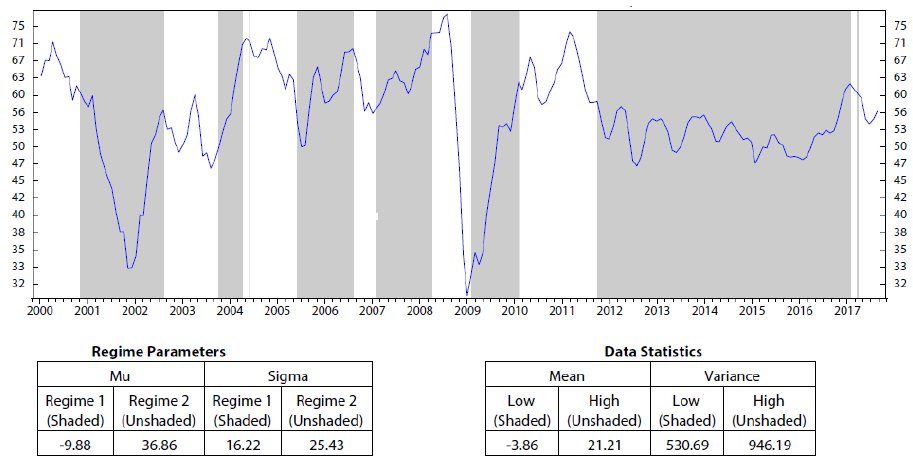
Figure A6. The world inflation expectation and its regimes detected using HMM for monthly data from 31 December 1999 to 31 August 2017. Regime 1 and regime 2 represent the low and high periods of the world inflation expectation,